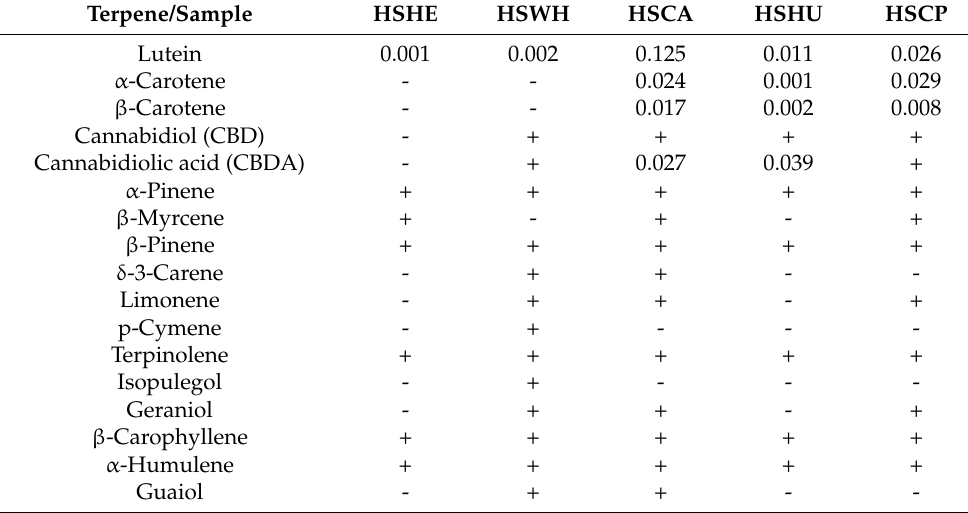
Table 4. Carotenoid, cannabinoid and terpene content in oil extracted from hemp hearts (HSHE), hemp whole seeds (HSWH), hemp cake (HSCA), hemp seed hulls (HSHU) and cold-pressed hemp oil (HSCP). Results are expressed in mg/g oil; concentration of terpenes is below the limit of quanti- tation